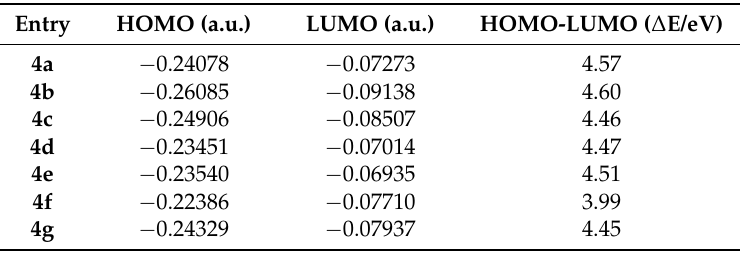
Table 2. HOMO and LUMO energies along with HOMO-LUMO energy gap of products 4a – g .